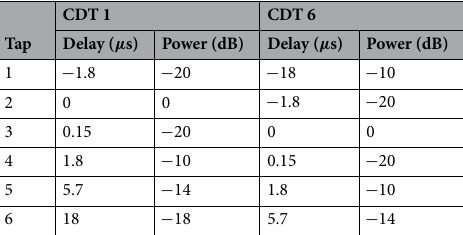
Table 2. Power delay profile for CDT 1 and CDT 6 multipath fading